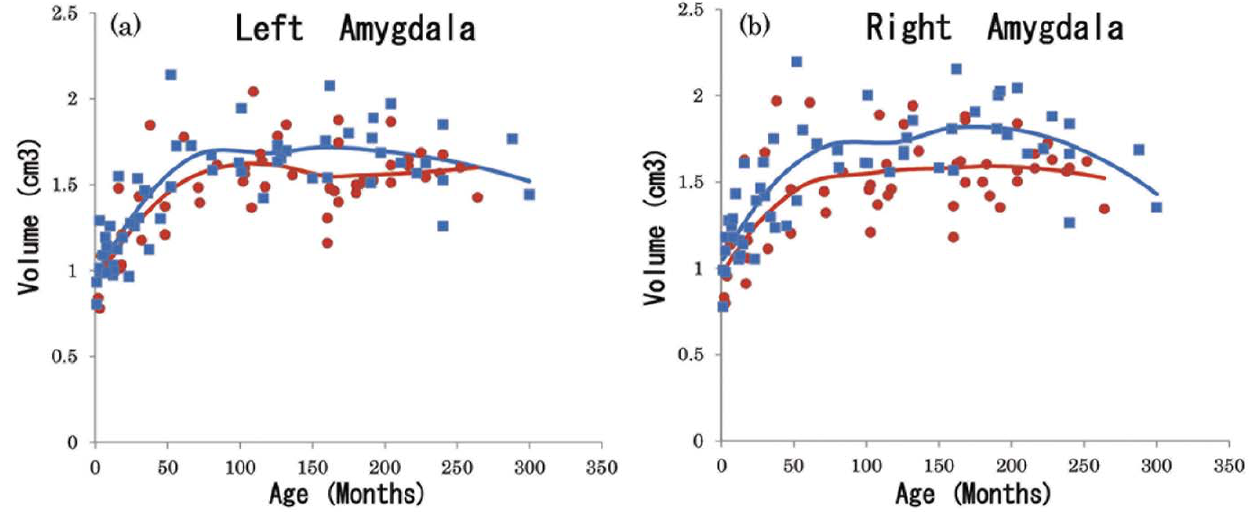
Figure 2. Scatter plots by monthly age and sex of absolute left and right amygdalar volume with locally weighted scatter plot smoothness (LOWESS). (a); LA: left amygdala, (b); RA: right amygdala, blue square: male (n=57), red circle: female (n=52), blue line: males’ LOWESS, red line: females’ LOWESS.